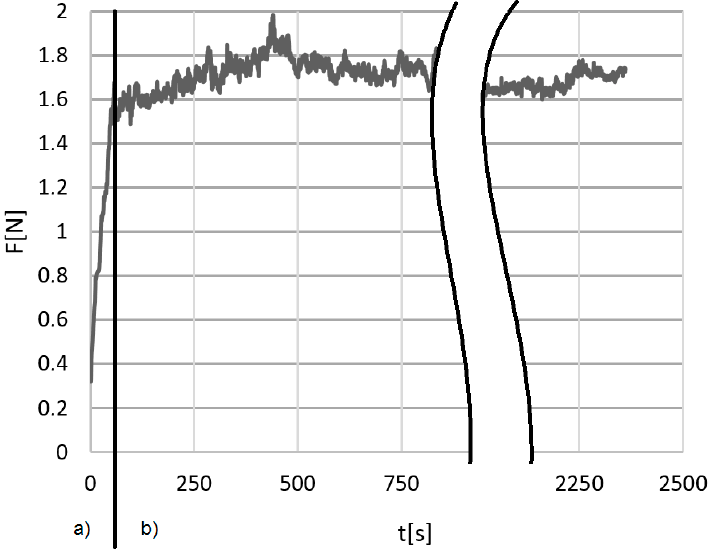
Figure 5. Exemplary time profile of the friction force F obtained during one of the tests: ( a ) running-in and ( b ) proper measurement period.